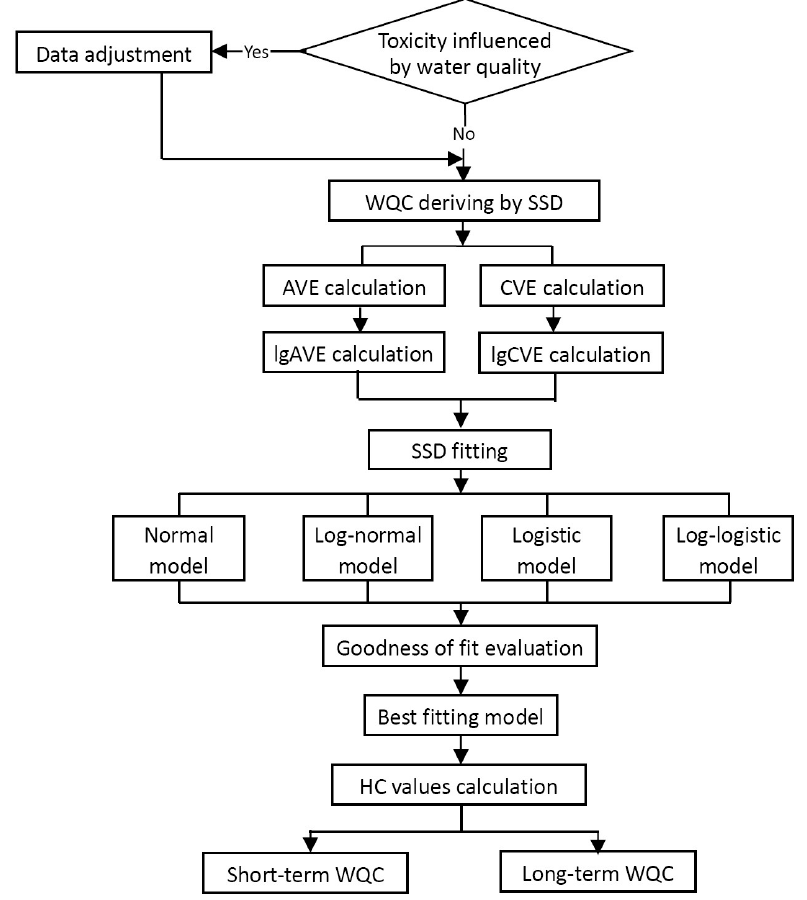
Figure 2. Derivation procedure of the freshwater WQC.